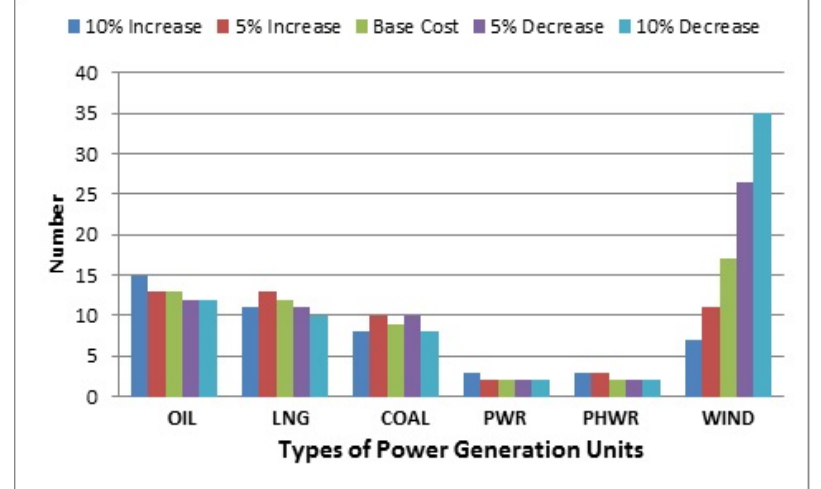
Figure 9. The impact of reducing the cost of investing wind farms in initial system investment.